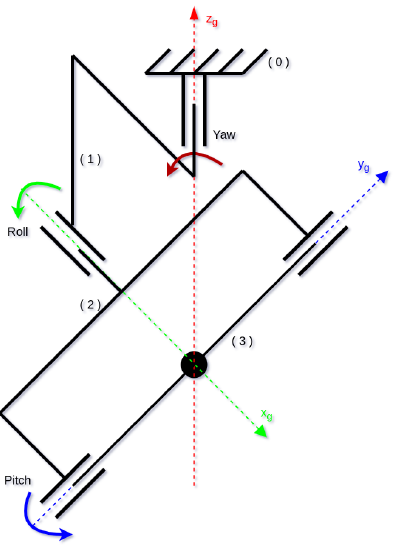
Figure 4. A three revolute joints Gimbal’s